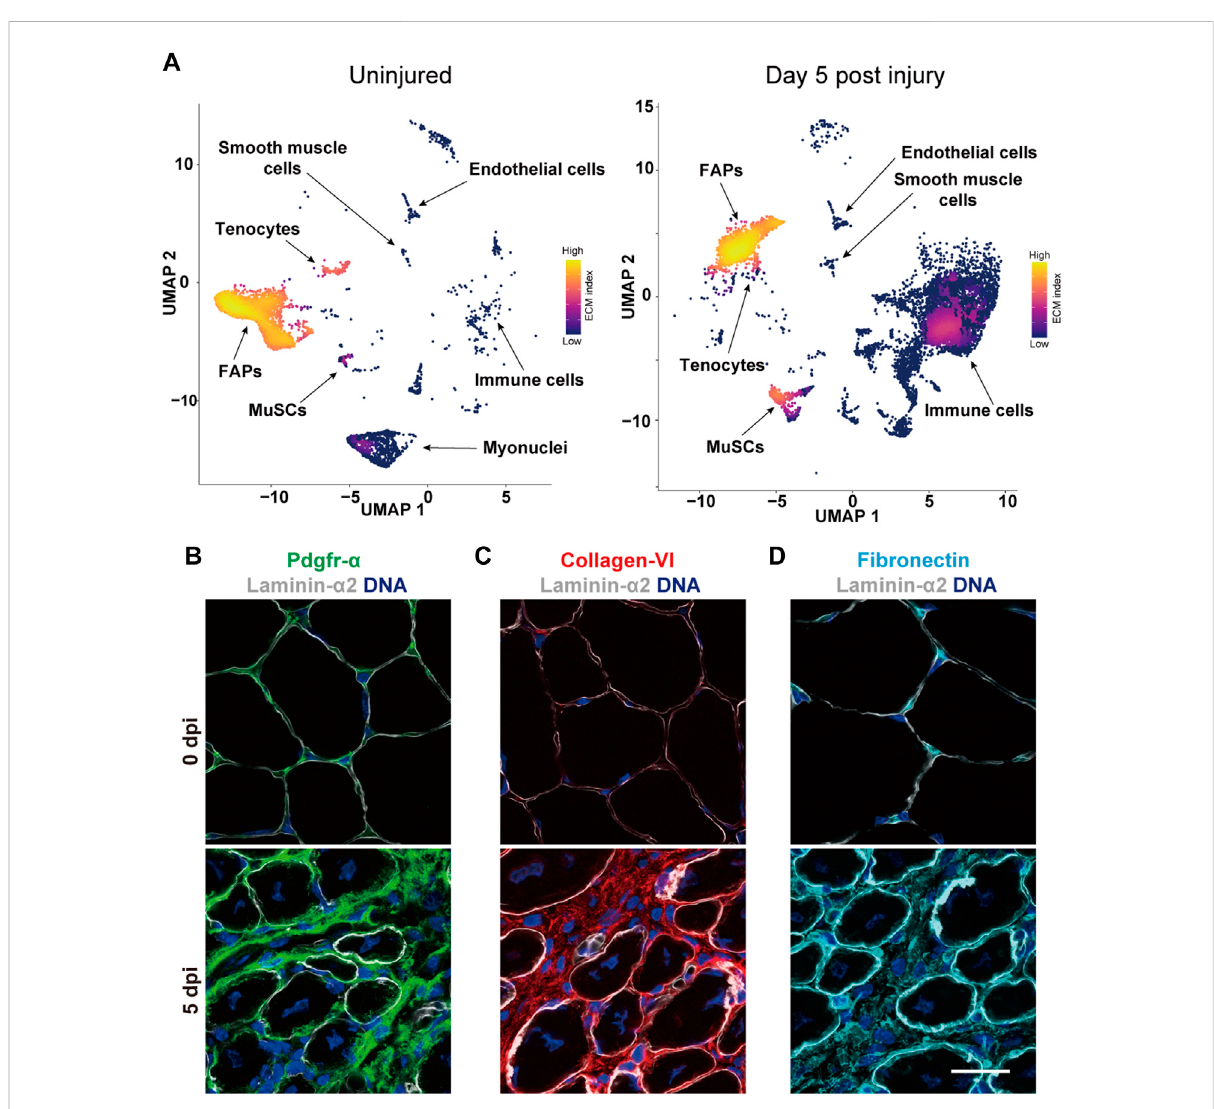
TheMuSCnicheinregeneratingskeletalmuscle. (A) Theimagesshowthejointgeneexpressiondensity(Alquicira-HernandezandPowell,2021) of an index of ~100 ECM genes obtained from the Matrisome database (Shao et al., 2020) in the UMAP projection (McInnes et al., 2018) of single cell RNA-sequencing data (Oprescu et al., 2020) deposited in the Gene Expression Omnibus (GEO) database (Barrett et al., 2013) from uninjured and regeneratingmouse skeletal muscleat5 days post injury.FAPs isshort for fi bro – adipogenicprogenitors. (B) Immunostainingofmouseskeletal musclecrosssectionsunderuninjuredconditions(0dpi)or5 dayspostinjury(5dpi)visualizingFAPsbasedonPdgfr α (green)co-stainedwithlaminin α 2 (white) and DNA (blue). (C,D) Immunostaining of mouse skeletal muscle cross sections at 0 or 5 dpi showing collagen IV (red), fi bronectin (turquoise), laminin α 2 (white) and DNA (blue). Scale bar = 20